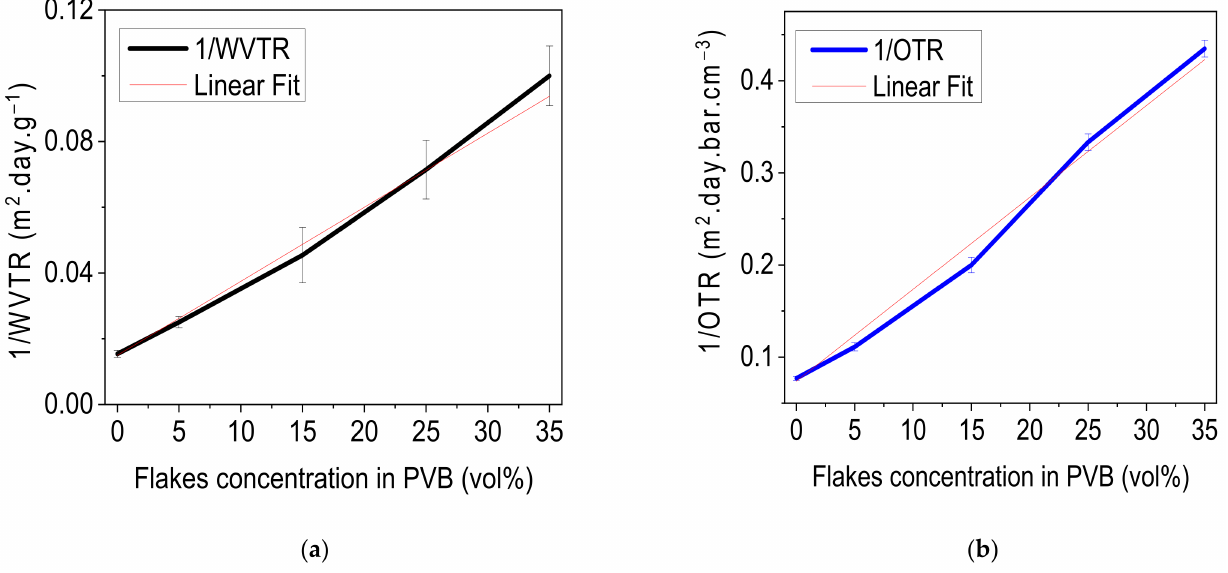
Figure 3. Barrier characteristics of PVB/mica composite, ( a ) inverse of WVTR (black curve), and ( b ) inverse of OTR (blue curve). Both curves show linear barrier improvement as a function of flake